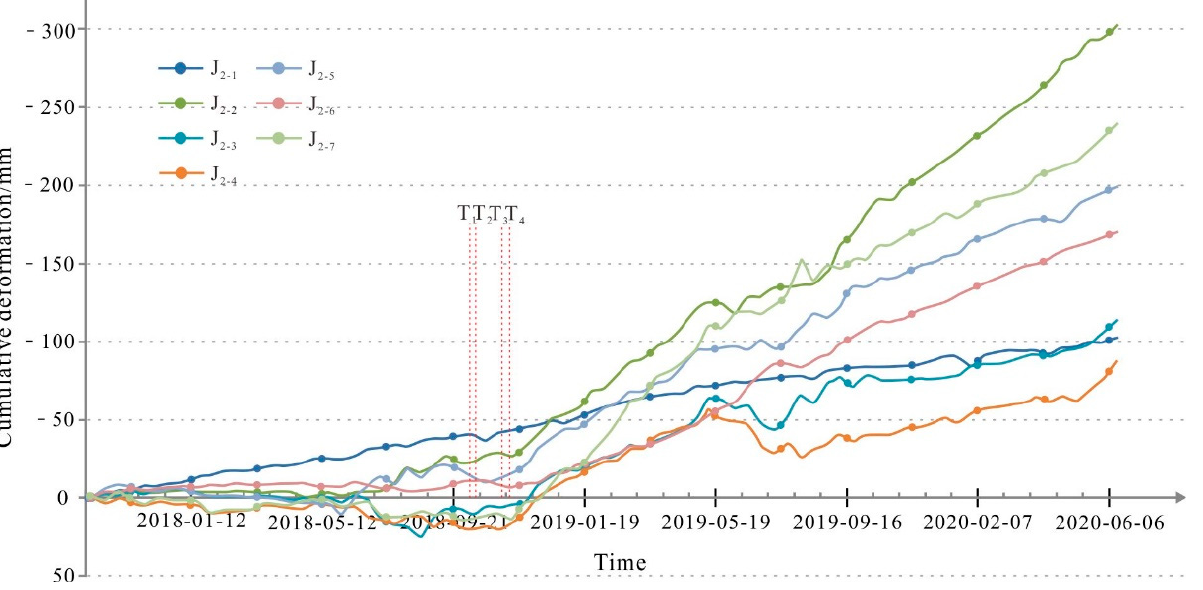
1 deformation body from October 2017 to